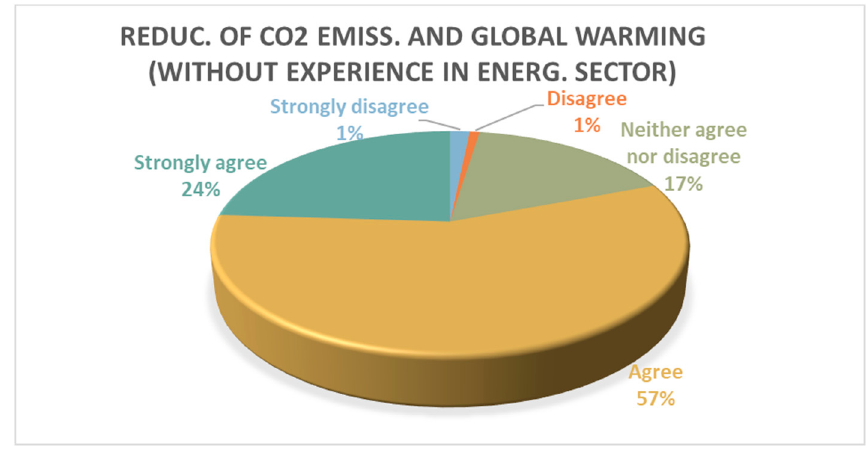
Figure 10. Participation of consumers without experience in the energy field in DR programs in order to reduce the CO 2 emissions and the climate change impact.